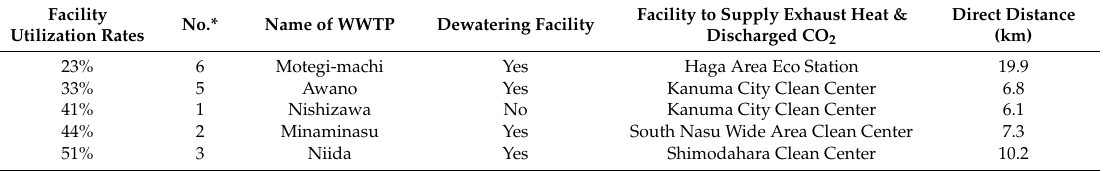
Table 1. Proximity of WWTP to facilities that supply exhaust heat and discharged CO 2